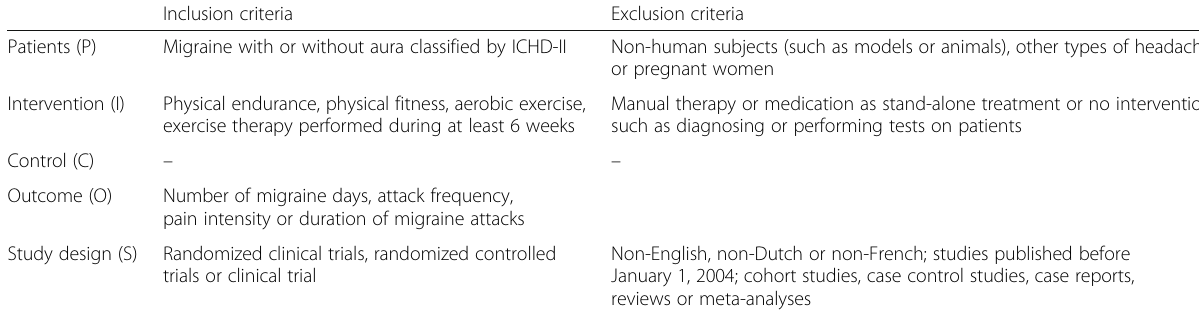
Table 1 PICOS and eligibility criteria Inclusion criteria Exclusion criteria Patients